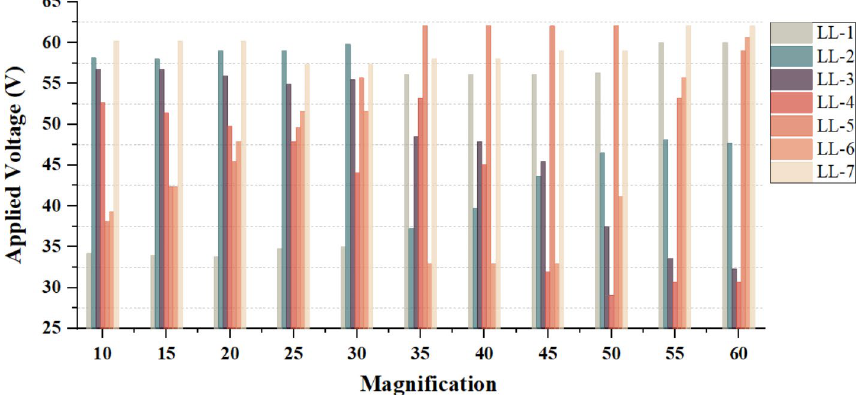
Fig. 7 Voltages applied to seven liquid lenses at different magnifications. (LL: Liquid lens)